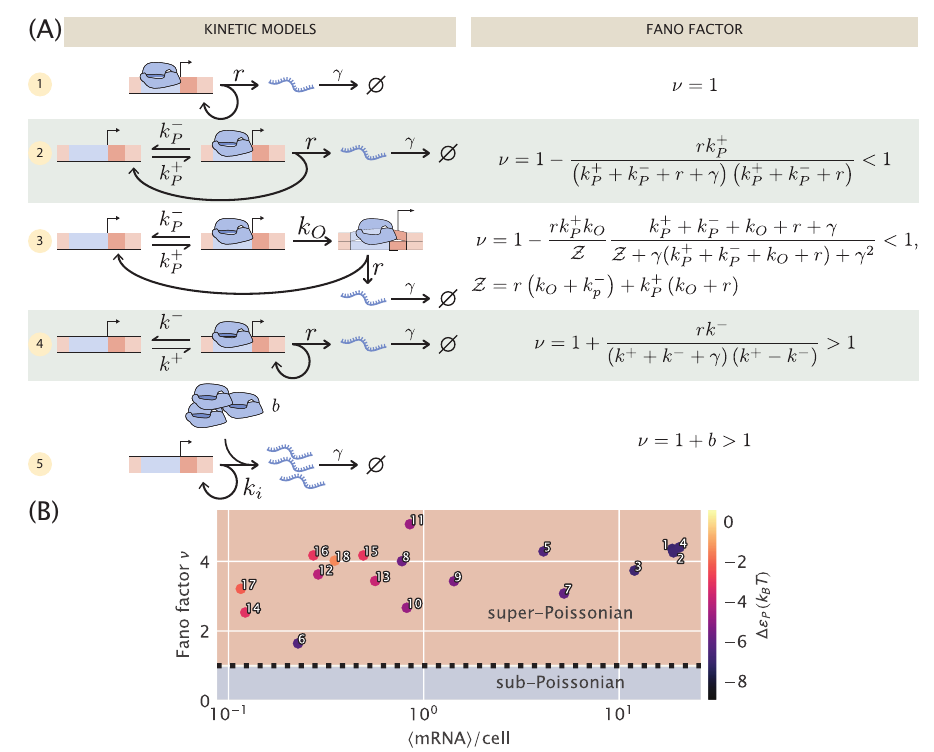
Fig 2. Comparison of different models for noise in the constitutive promoter. (A) The left column depicts various plausible models for the dynamics of constitutive promoters. In model (1), transcripts are produced in a Poisson process [32, 33]. Model (2) features explicit treatment of RNAP binding/unbinding kinetics [45]. Model (3) is a more detailed generalization of model (2), treating transcription initiation as a multi-step process proceeding through closed and open complexes [46]. Model (4) is somewhat analogous to (2) except with the precise nature of active and inactive states left ambiguous [17, 21, 47]. Finally, model (5) can be viewed as a certain limit of model (4) in which transcripts are produced in bursts, and initiation of bursts is a Poisson process. The right column shows the Fano factor ν (variance/mean) for each model. Note especially the crucial diagnostic: (2) and (3) have ν strictly below 1, while only for (4) and (5) can ν exceed 1. Models with Fano factors � 1 cannot produce the single-cell data observed in part (B) without introducing additional assumptions and model complexity. (B) Data from [33]. Mean mRNA count vs. Fano factor (variance/mean) for different promoters as determined with single-molecule mRNA Fluorescence in situ Hybridization. The colorbar indicates the predicted binding affinity of RNAP to the promoter sequence as determined in [48]. Numbers serve for cross comparison with data presented in Fig